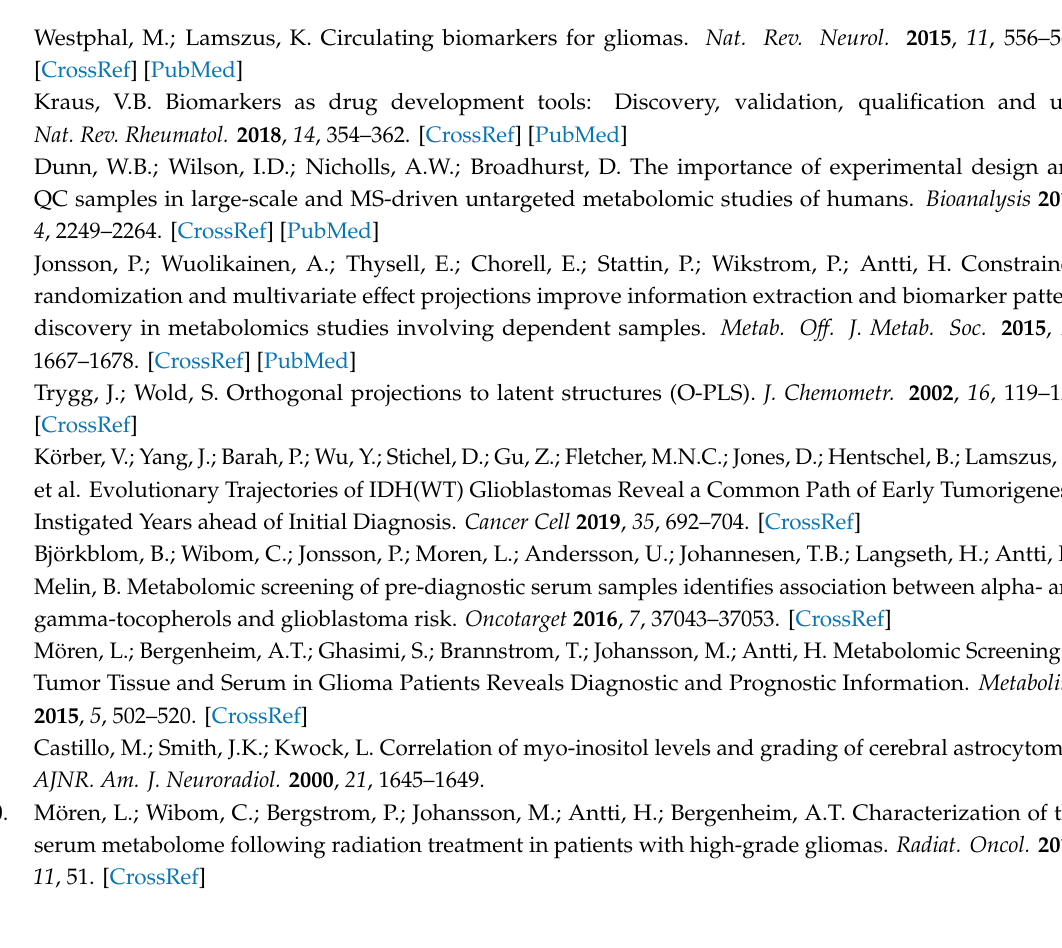
Figure S1: Comparison of SMART-observation distribution pattern for individual metabolites to random data, Table S1: Characteristics of the study population with pre-diagnostic repeated blood samples, Table S2: Characteristics of the study population with pre-diagnostic single blood